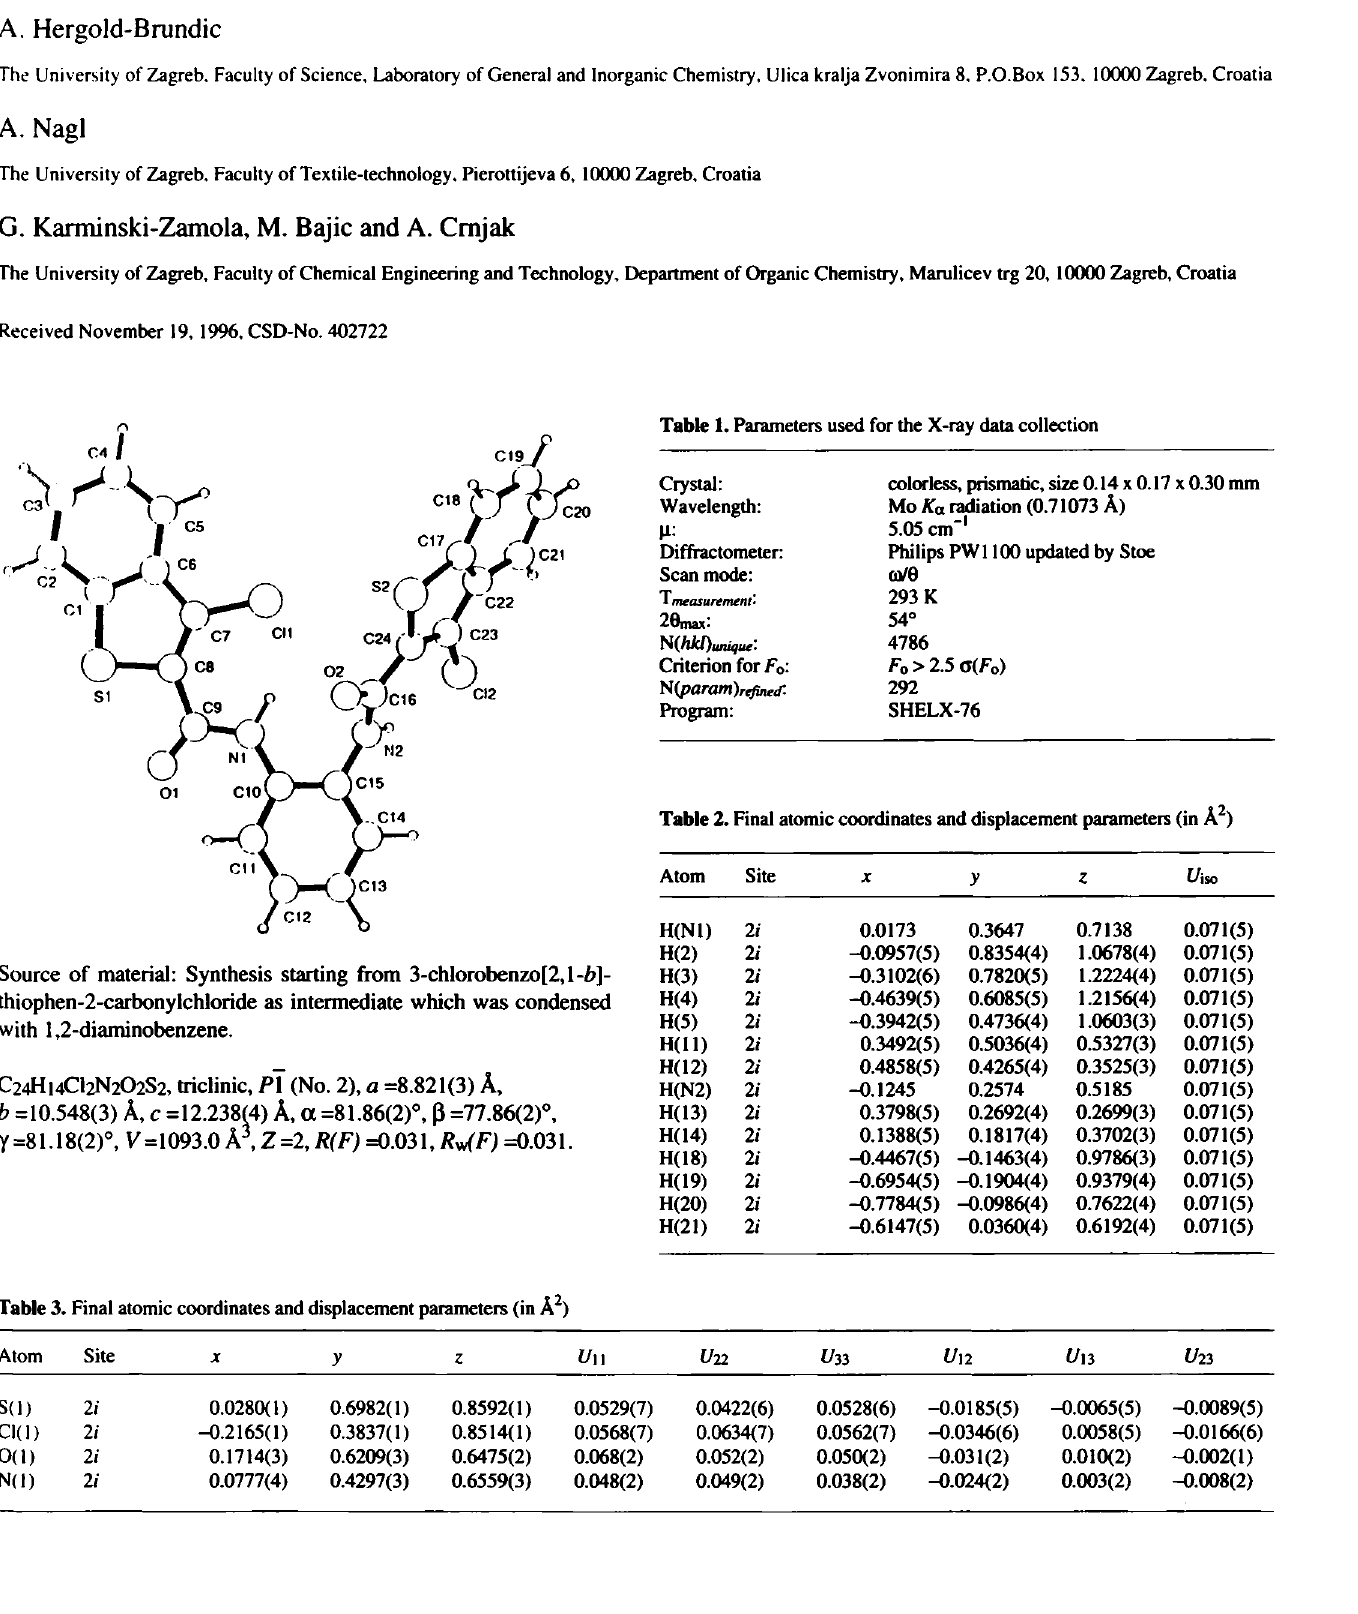
Table 3. Final atomic coordinates and displacement parameters (in Â 2